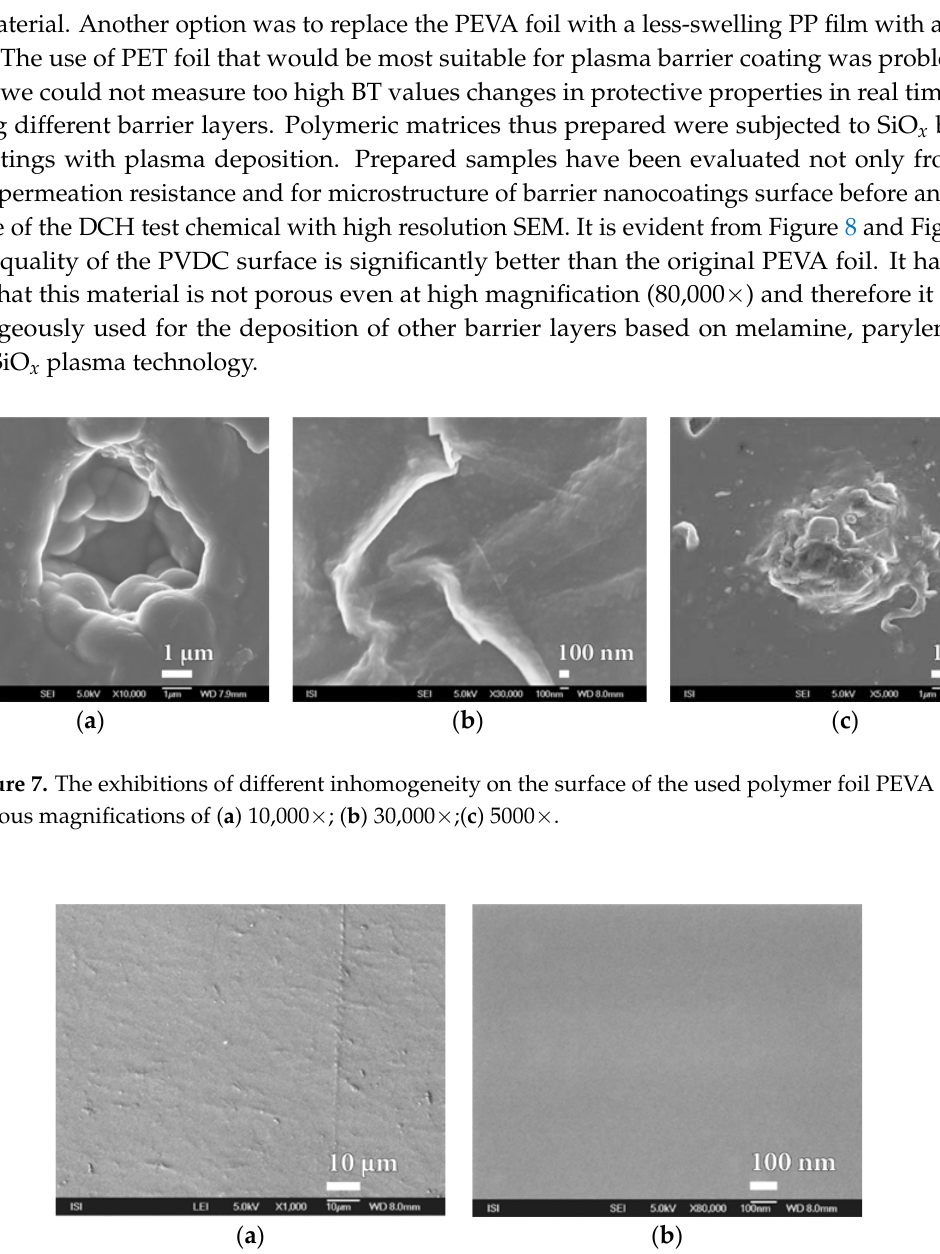
Figure 8. SEM micrographs of PVDC foil surface laminated at 110 °C to PEVA foil at magnification of ( a ) 1000× and ( b ) 80,000×.